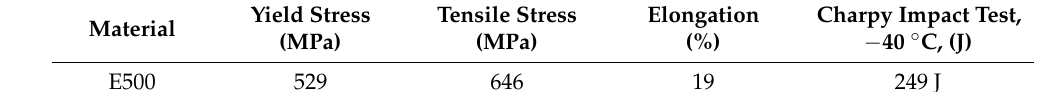
Table 2. Mechanical properties of E500 steel.